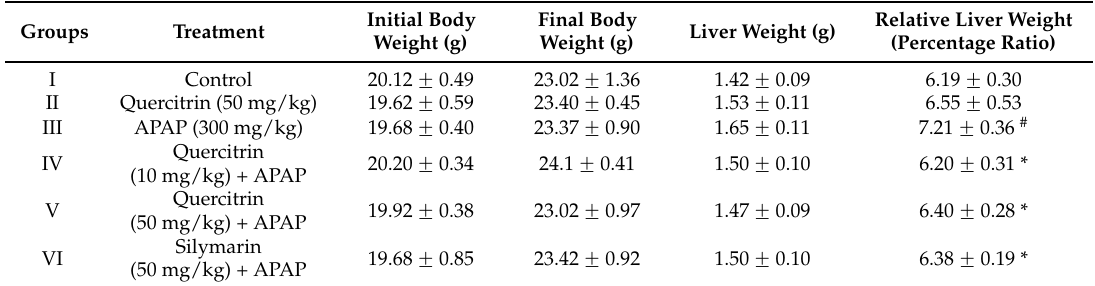
Effect of quercitrin on body weight and liver weight/body weight (%) in APAP intoxicated